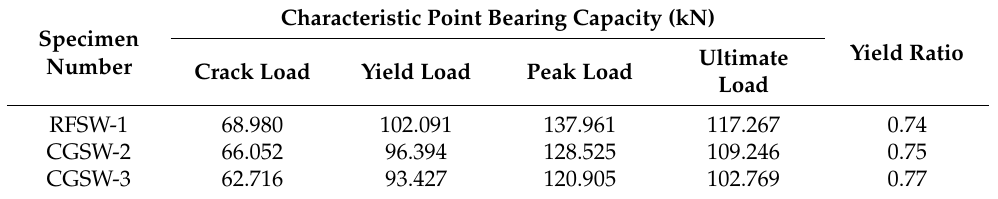
Table 6. Characteristic point bearing capacity of the specimens.